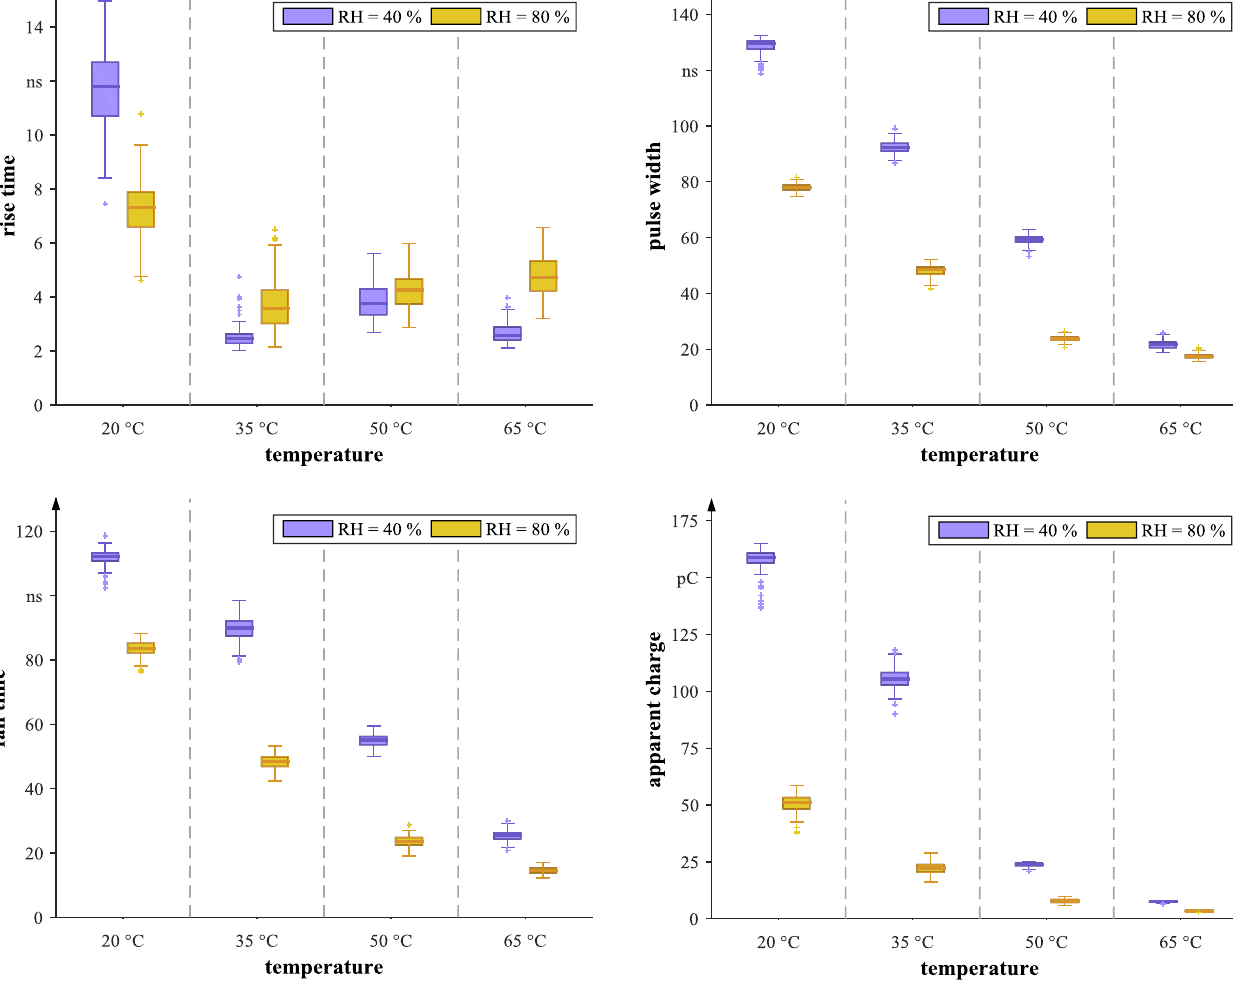
Fig. 8. Box plots for the pulse shape parameters rise time (top left), pulse width (top right), fall time (bottom left) and the apparent charge (bottom right) of positive corona discharges occuring under a varying temperature level for relative humidity levels of 40 % and 80 %.